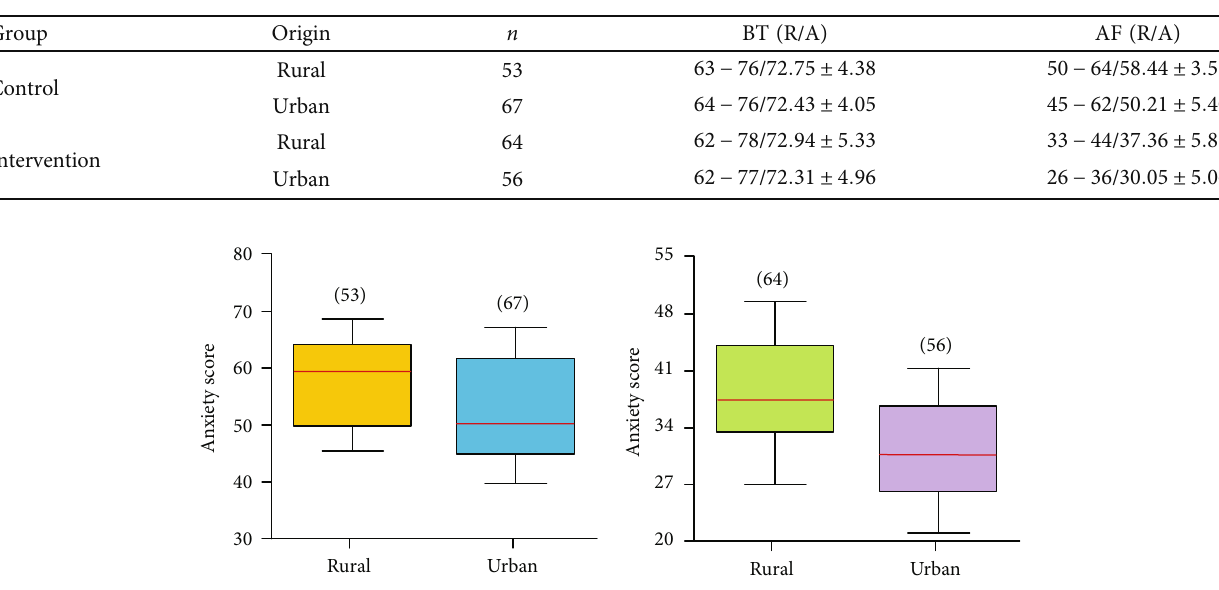
Figure 3: Anxiety evaluation results of college students with di ff erent majors in the control and intervention groups after treatment. Table 6: Comparison of anxiety evaluation results of college students with di ff erent origins in the control and intervention groups before treatment (BT) and after treatment (AT) ( (cid:1) x ± s ). Note: R: range; A: average.